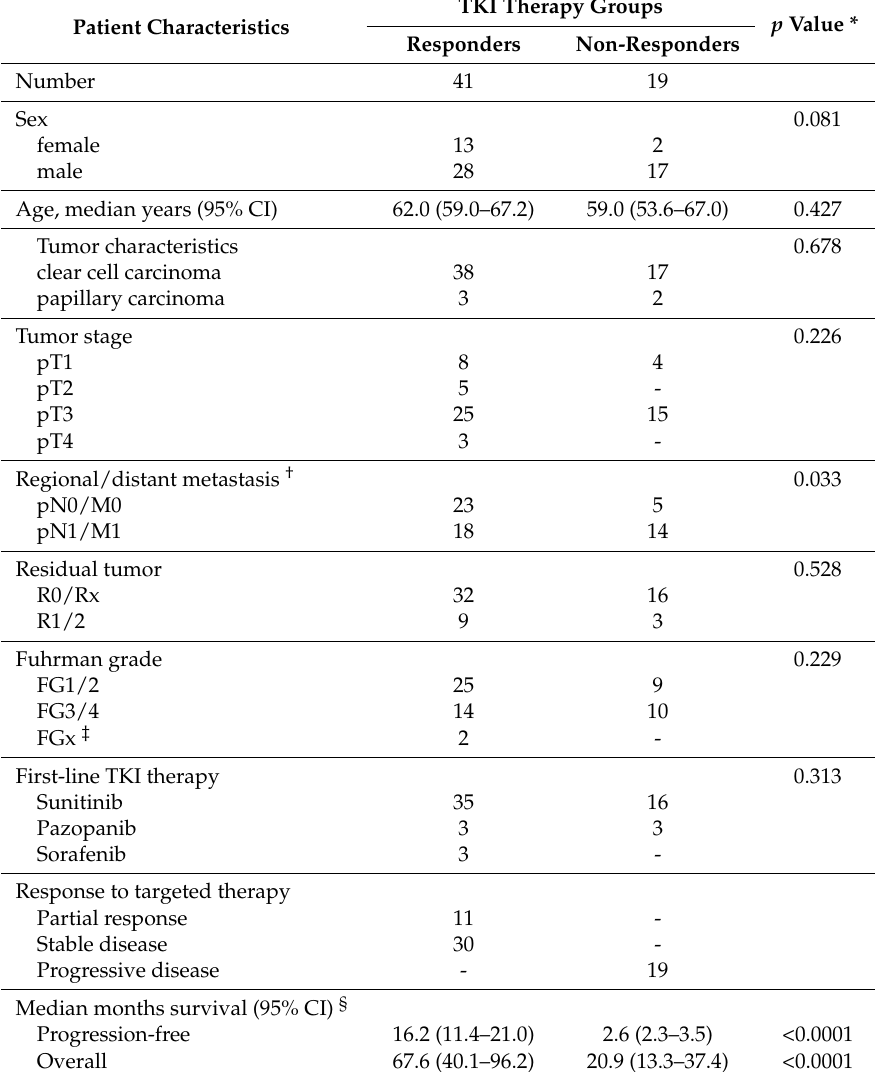
Table 1. Clinicopathological characteristics of the metastatic renal cell carcinoma cohort after radical nephrectomy classified as responder and non-responder patients to a first-line tyrosine kinase inhibitor